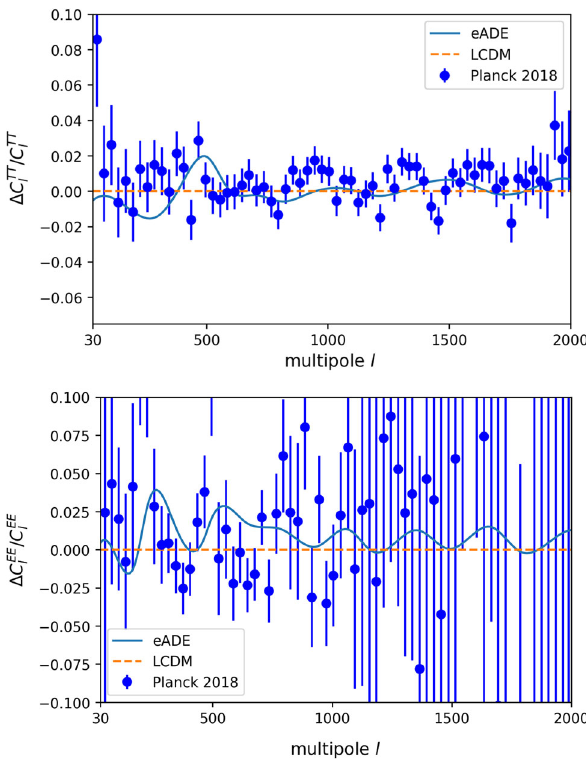
Fig. 3 The (cid:14) C l isthechangebetweentheeADEmodelandthe (cid:2) CDM for the CMB power spectra in TT and EE mode